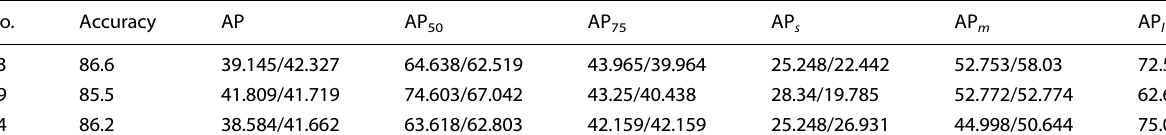
Table 2. Model performance on X-ray pytchography image (bounding box/segmentation mask). No.